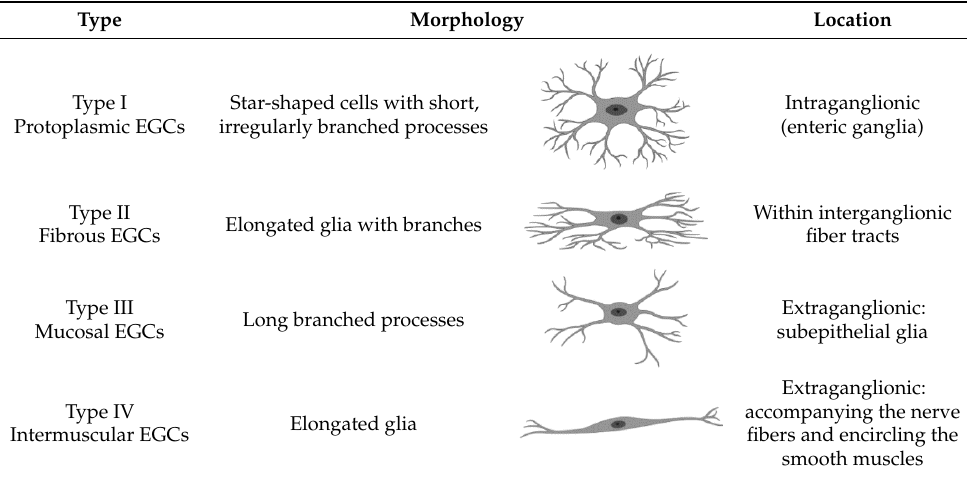
Table 1. Division of the enteric glial cells into subtypes.